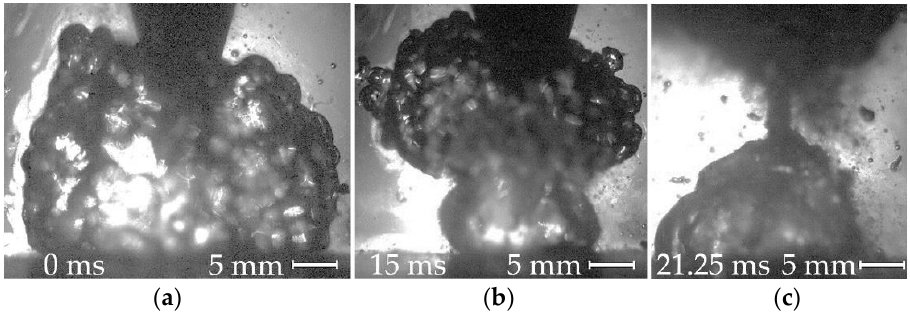
Figure 2. Dynamics of the vapor gas bubble during underwater wet cutting using flux-cored wire: ( a ) arc deepening in the metal, vapor gas bubble stabilization; ( b ) vapor gas bubble collapse and new bubble formation; ( c ) old bubble detachment, new bubble expansion.